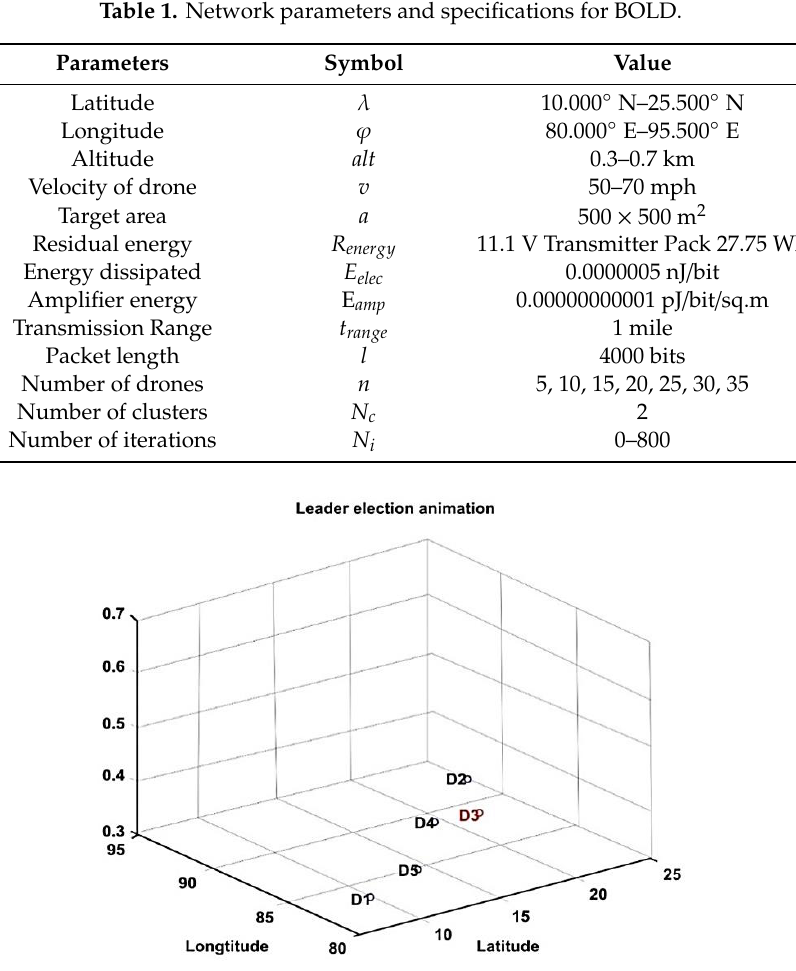
Figure 8. Network topology with 5 drones and the red color denotes the CH.